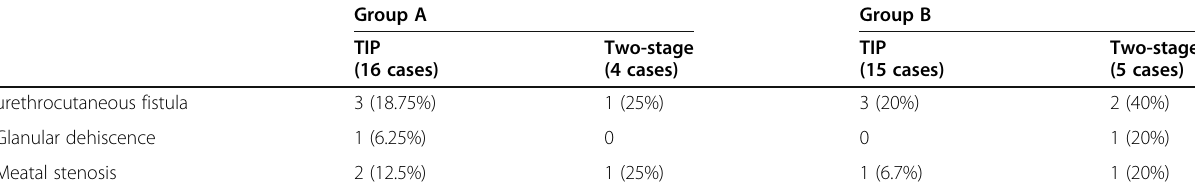
Table 3 Distribution of postoperative complications among both study